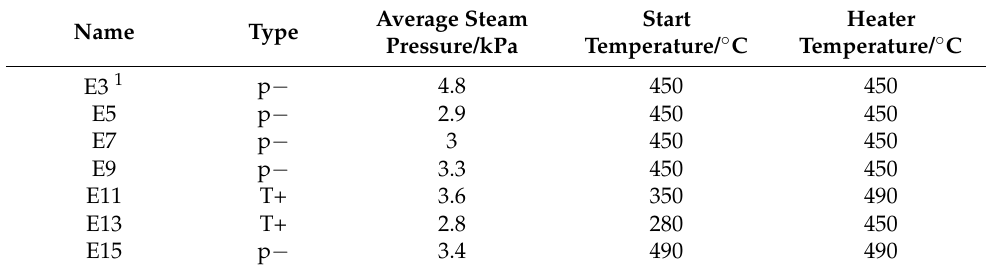
Table 2. Overview of the dehydration